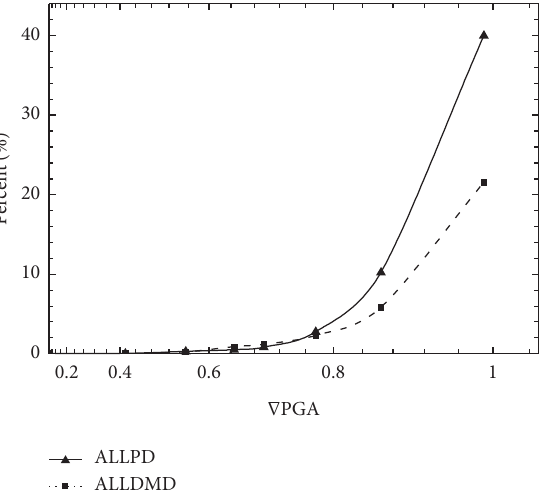
Figure 14: Dissipated energy growth rate.